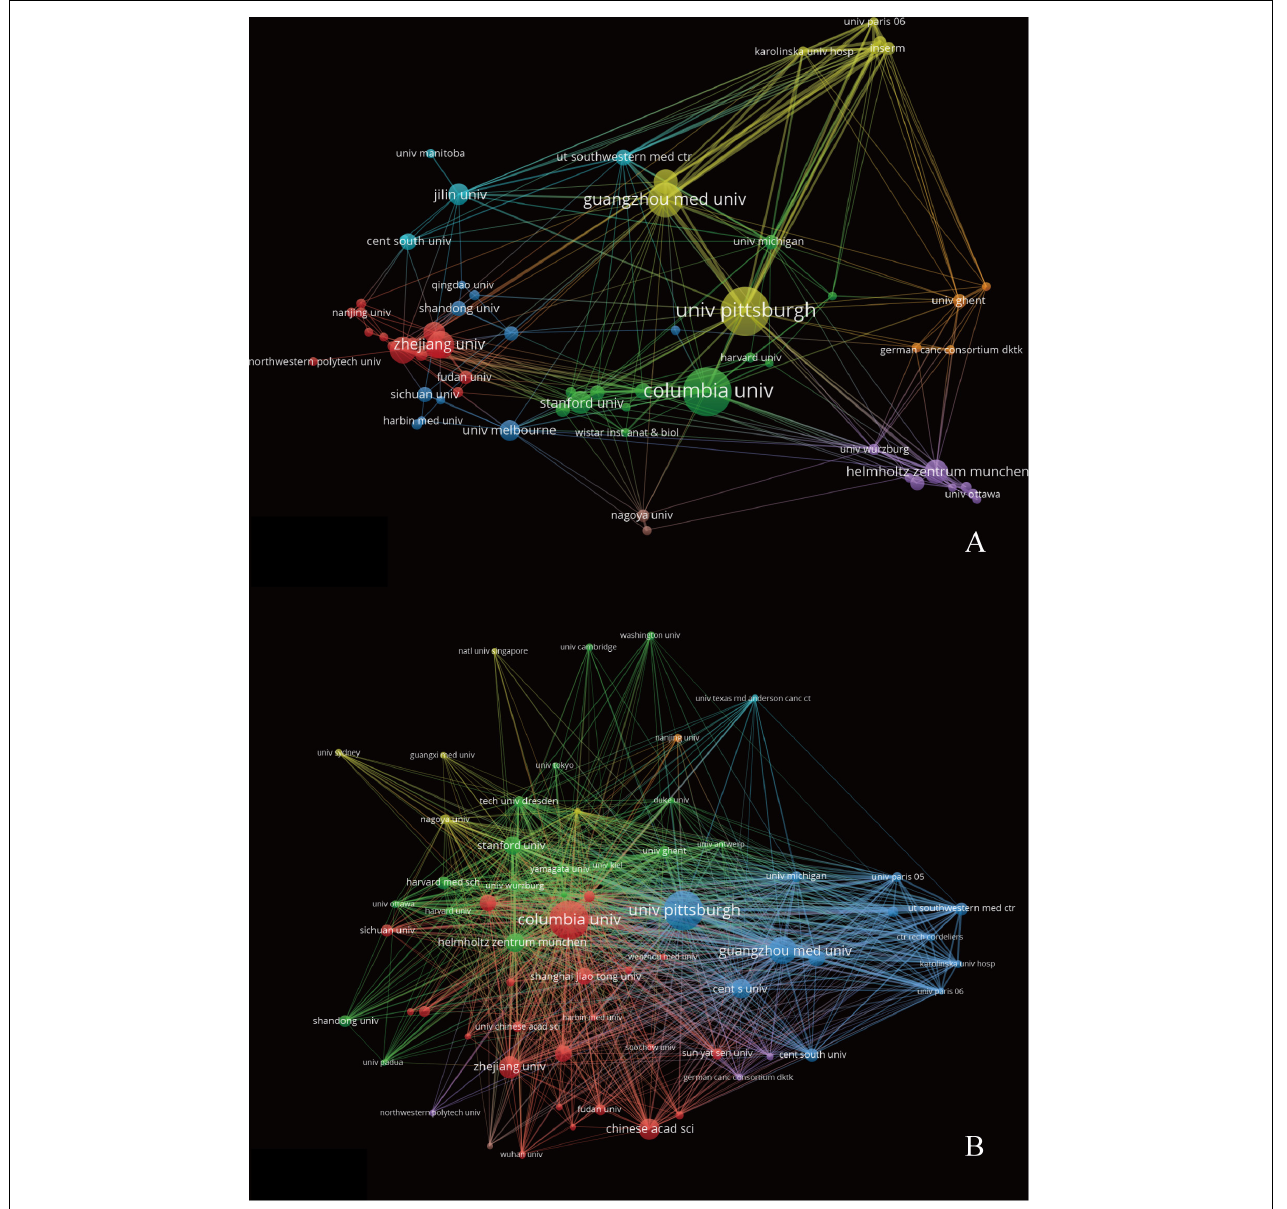
FIGURE 5 | The institutions’ collaboration (A) and citation (B) network visualization map generated by VOS viewer